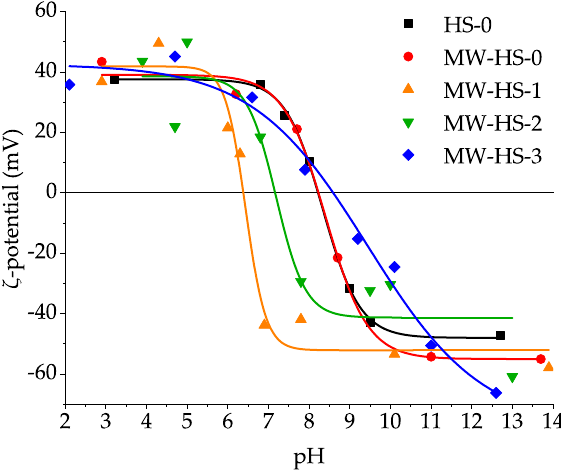
Figure 6. ζ -potentials of all samples in water solutions in a wide pH range.